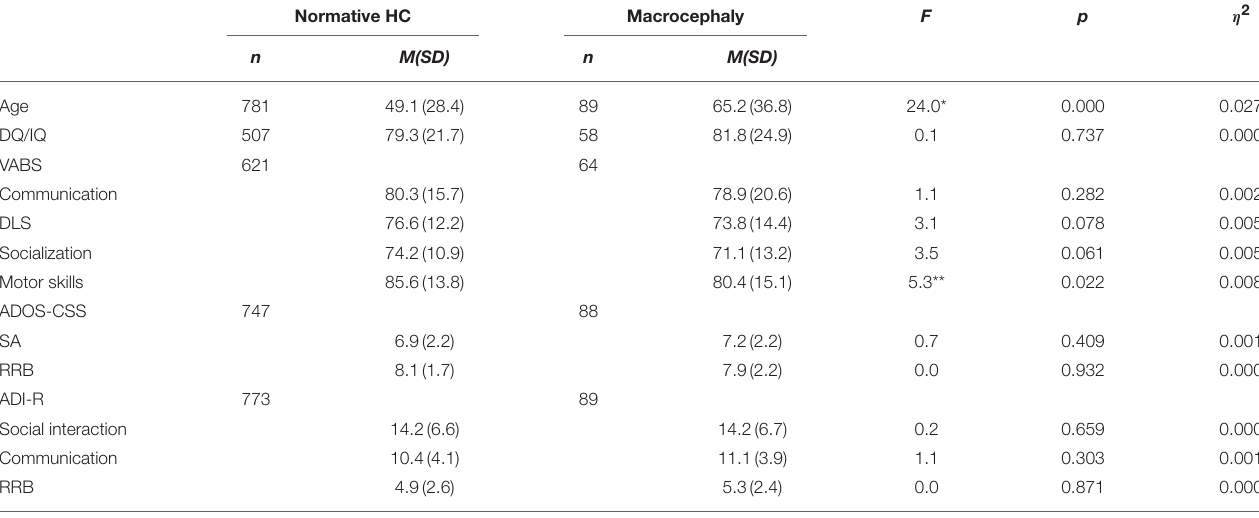
TABLE 1 | Mean and SD of cognitive scores, VABS scores and autism severity measures for the normative and macrocephaly groups. Normative HC Macrocephaly F p η 2